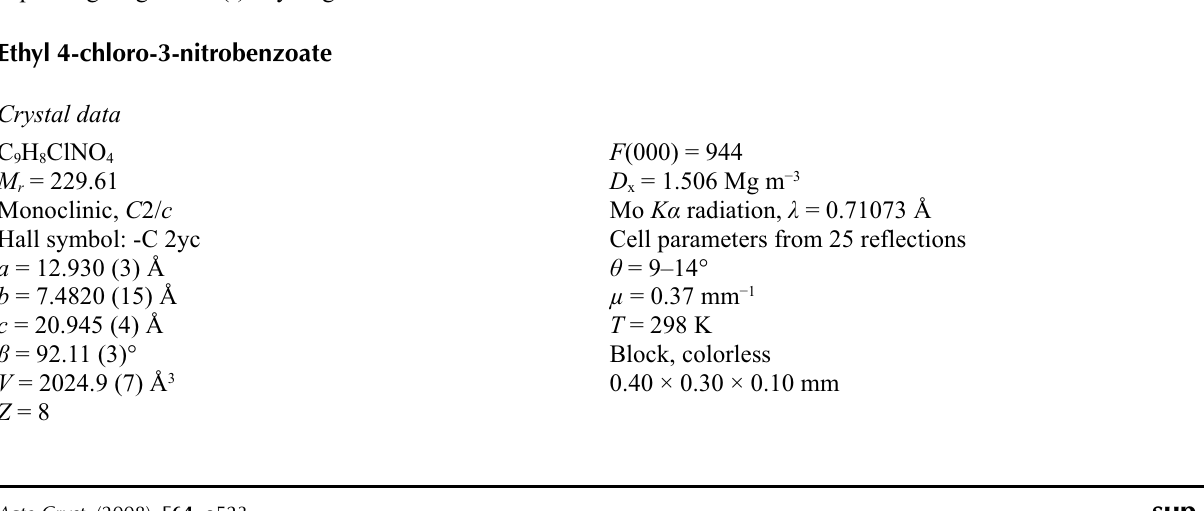
Figure 2 A packing diagram of (I). Hydrogen bonds are shown as dashed